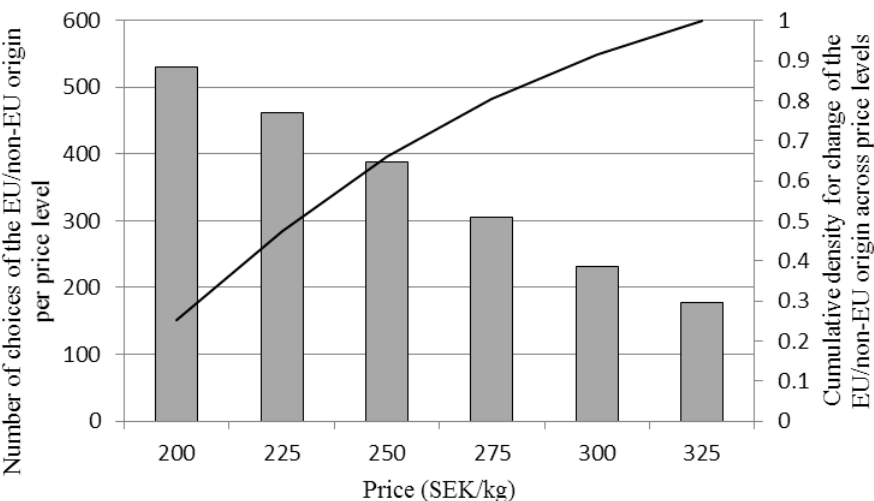
Figure 4. Histogram and cumulative density function for the levels of the price attribute when the EU/non-EU origin alternative was selected in the choice experiment.